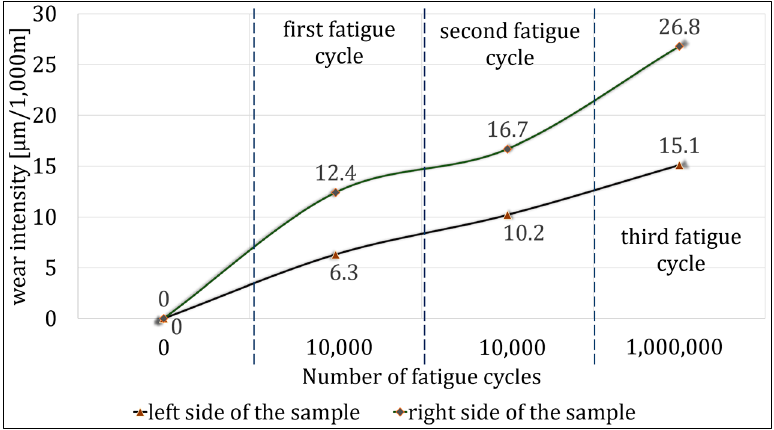
Figure 12. Shaft wear intensity.